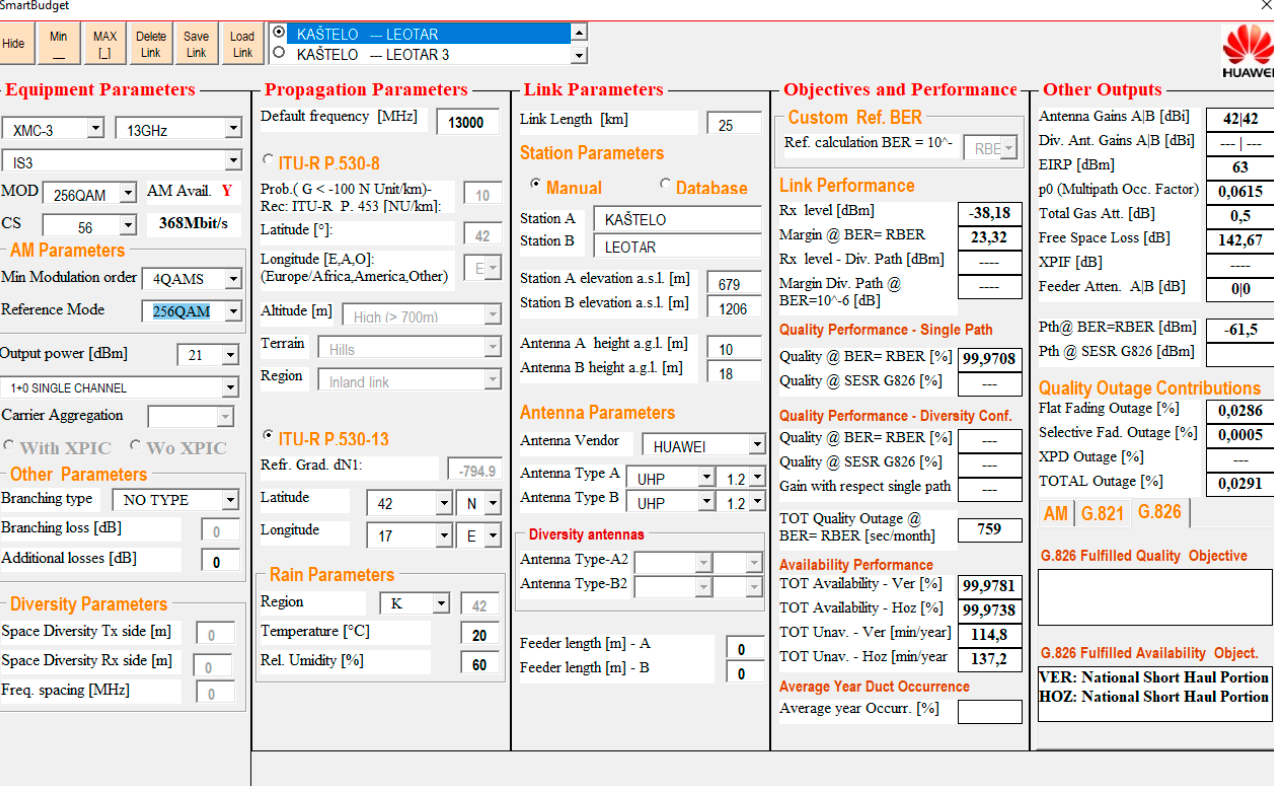
Figure 15. Prediction for the fifth RR section; 256 QAM, 368 Mb/s.